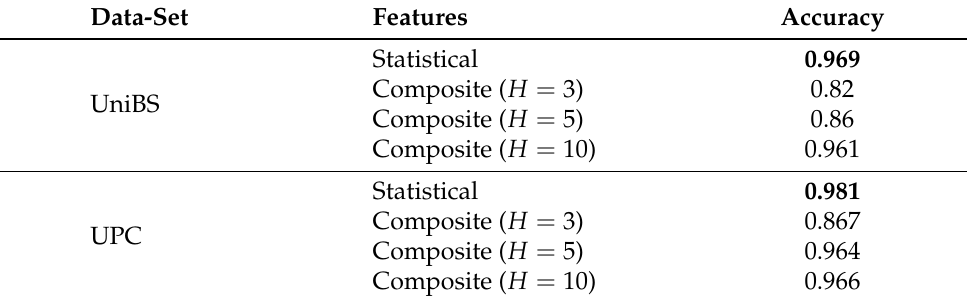
Table 8. Performance achieved by the C4.5 classifier.